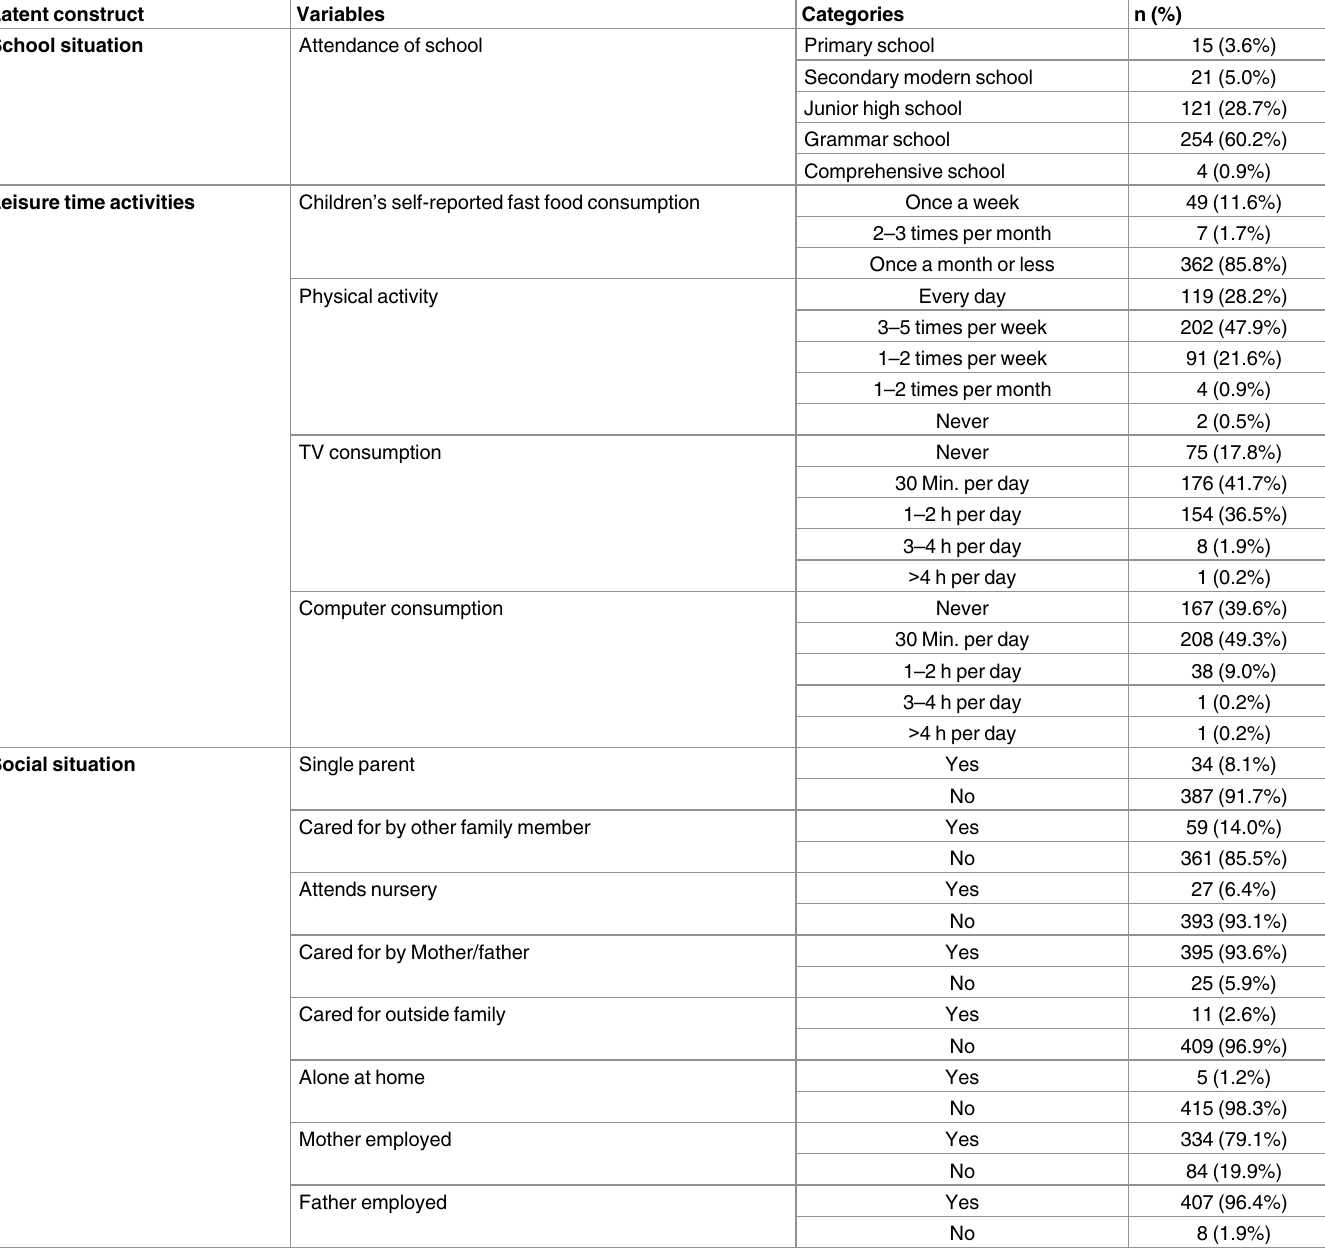
Table 2. Sample characteristics of participating children in the total sample for socio-economic and questionnaire variables targeting physical activity, food intake, TV and computer consumption at age 11, not stratified according to gender; missings per row were very low (0.2–1.9%) and not reported in